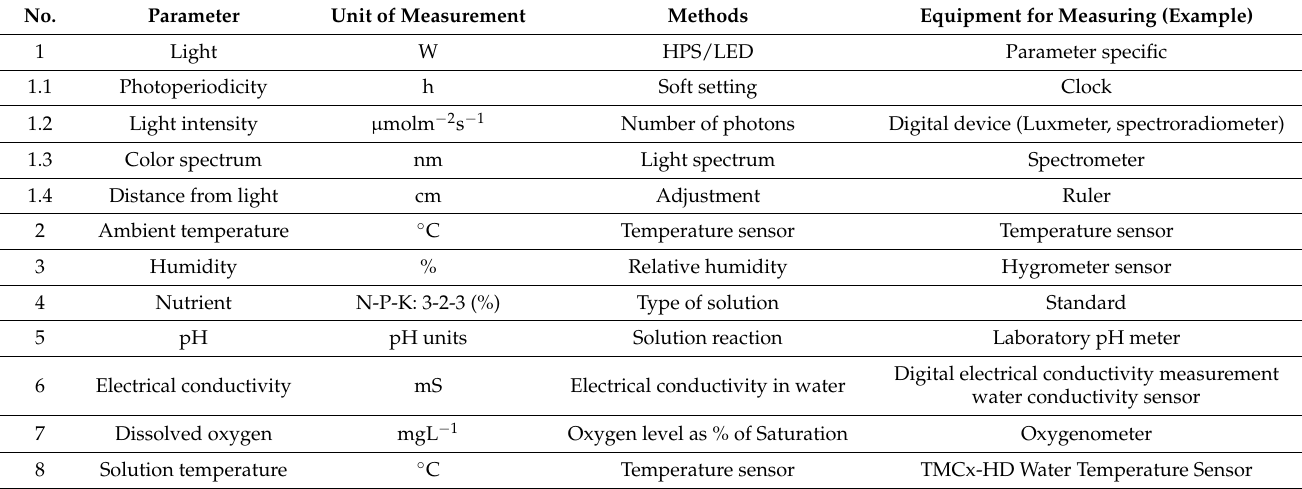
Table 2. Recommended measurement methods and